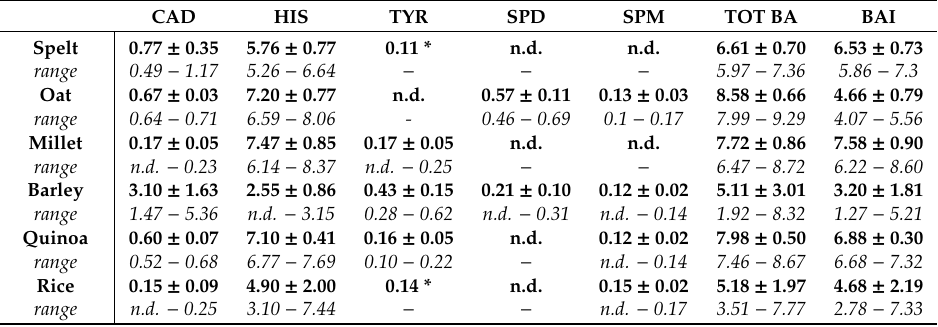
Table 2. Mean concentrations (mg/L ± Standard Deviation) and range of biogenic amines by cereal class. CAD